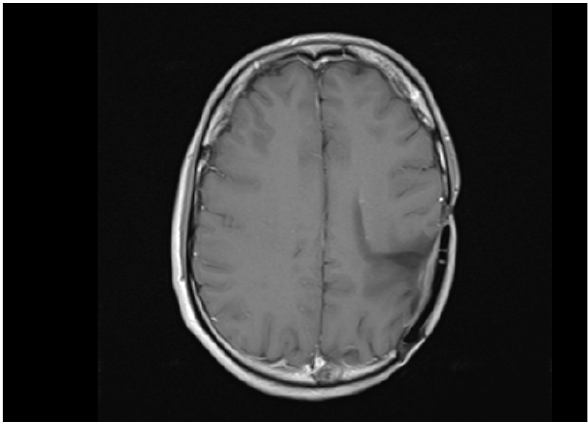
Fig. 2a. Axial T1-weighted MRI scan showing no contrast- enhanced lesion.